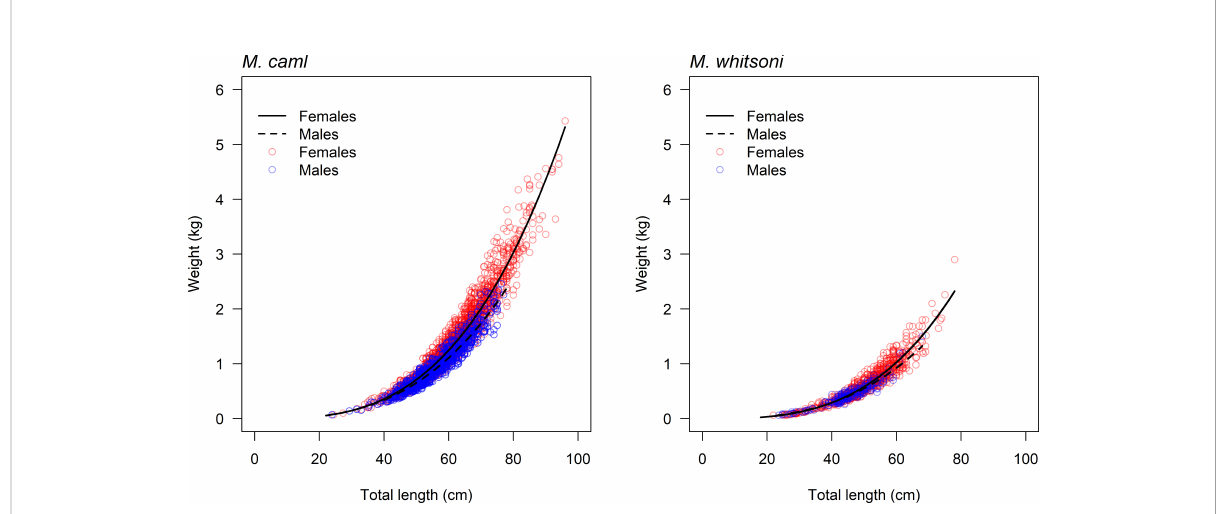
FIGURE 2 Weight-at-length data and fi tted length-weight curves for female and male Macrourus caml (left) and M. whitsoni (right) in the Ross Sea region.